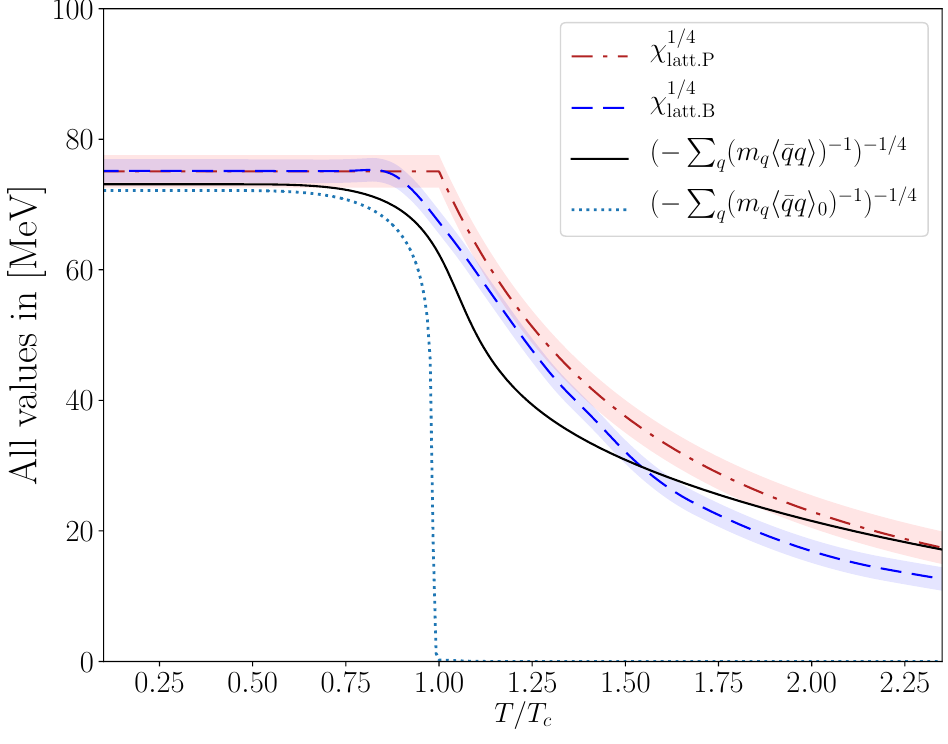
Figure 5. The relative-temperature T / T c dependence of (the leading term of) χ ( T ) 1 / 4 from our often adopted [17,30–32,48] isosymmetric DSE rank-2 separable model: solid curve for Equation (9) with massive-quark condensates, while the dotted curve results from using ⟨ ¯ qq ⟩ 0 instead. χ ( T ) 1 / 4 (with uncertainties) from lattice: dash-dotted curve extracted from Petreczky et al. [70] and long-dashed curve, from Borsany et al. [71]. (Colors